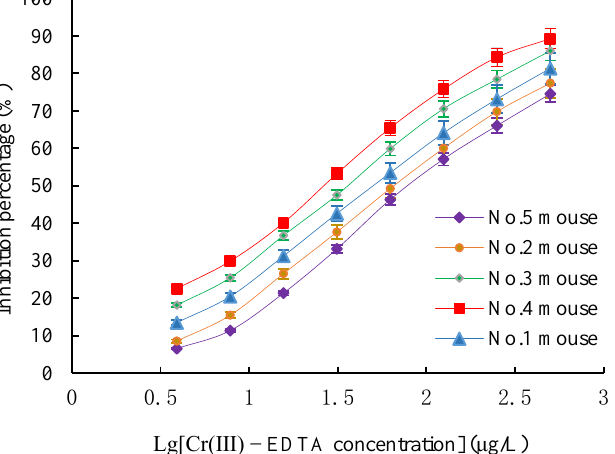
Figure 3. Sensitivity measurement of Cr(III)-EDTA pAb against Cr(III)-EDTA via icELISA. icELISA: indirect competitive ELISA.